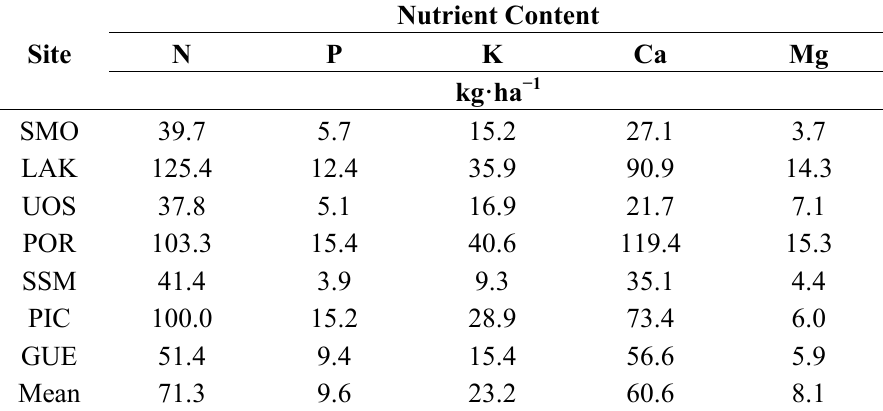
Table 2. Potential nutrient removal as determined from total nutrient content (N, P, K, Ca, and Mg) of harvested biomass (stems) by S. purpurea “Hotel” in seven